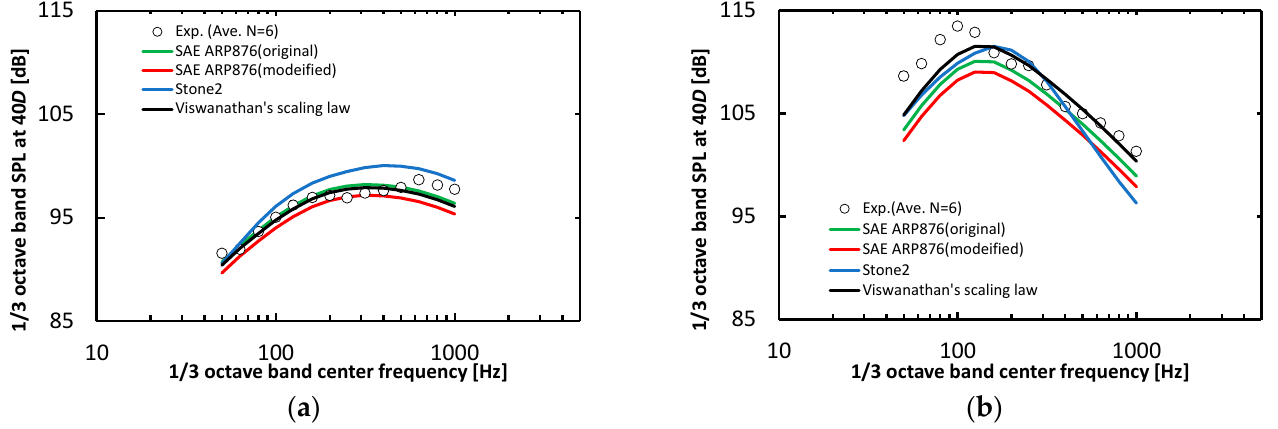
Figure 7. Comparison between the predicted and measured jet noises for single-engine operation at N1 = 95%, jet velocity =322 m/s, and TTR = 1.5: ( a ) θ = 90°; ( b ) θ = 150°.